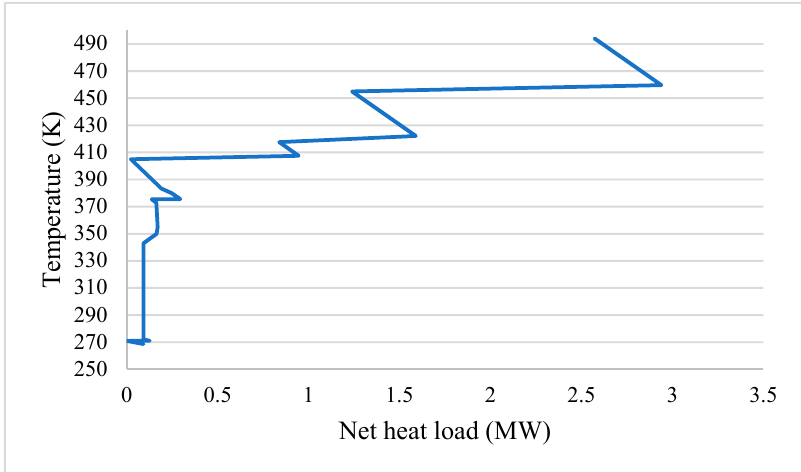
Figure 21. Scenario (1 + 2 + 3) design.